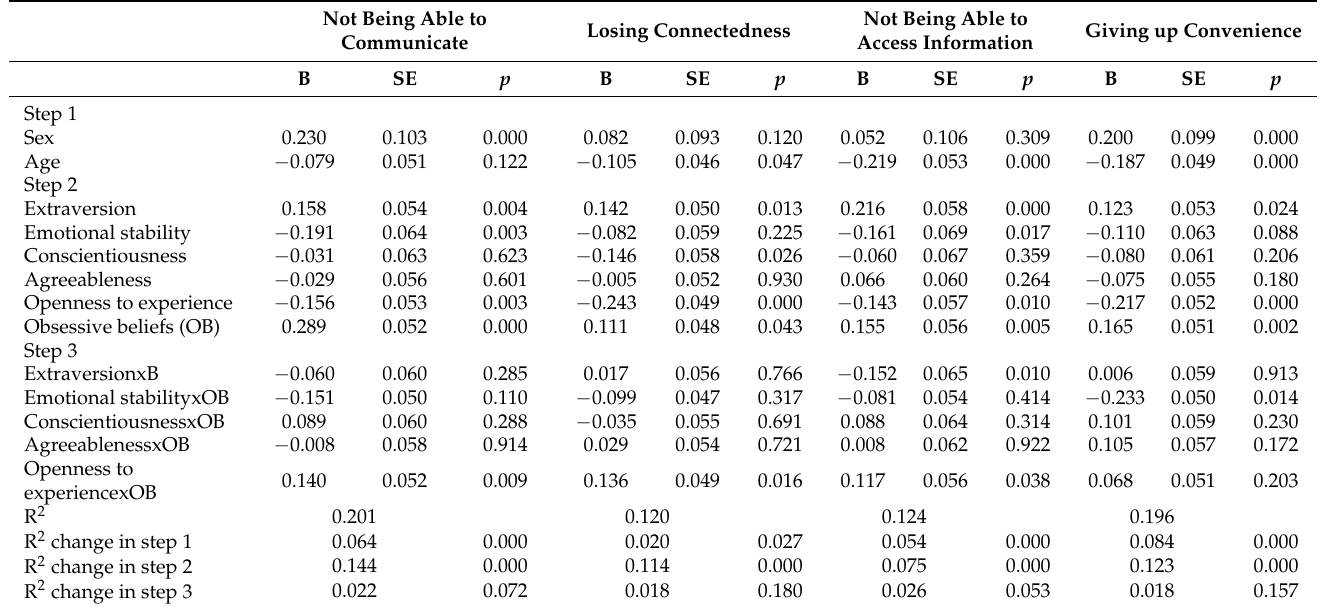
Table 2. Hierarchical multiple regression analysis of personality traits and obsessive beliefs in predicting